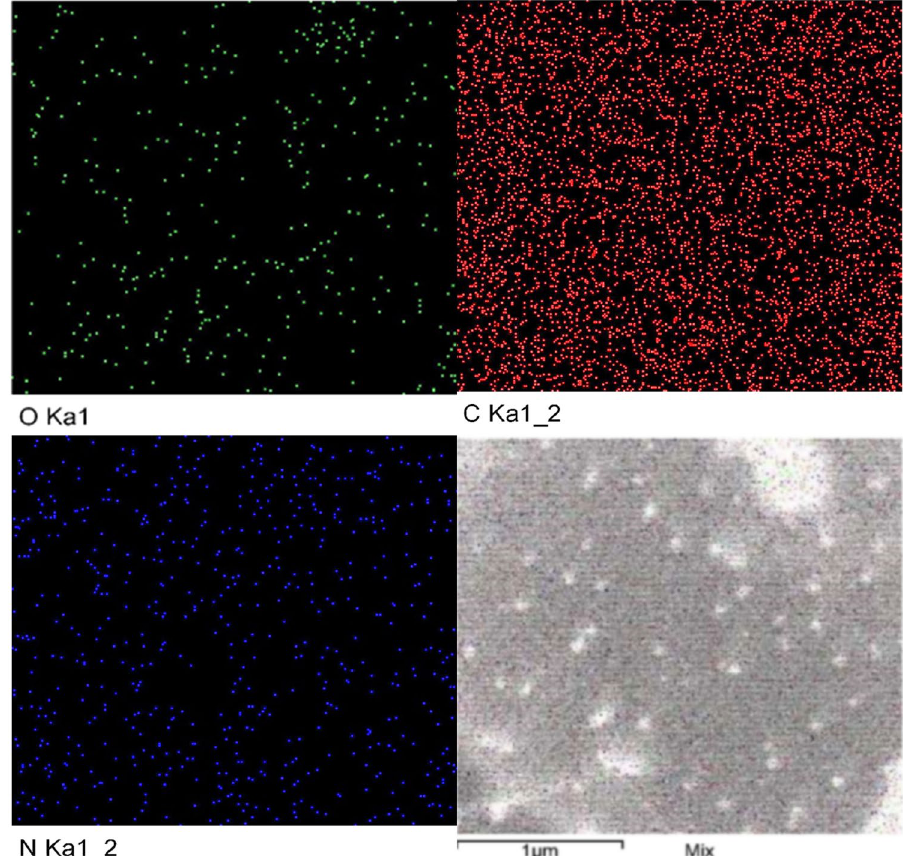
Figure 7. Mapping analysis of chitosan nanoparticles bio-synthesized using Streptomyces microflavus strain